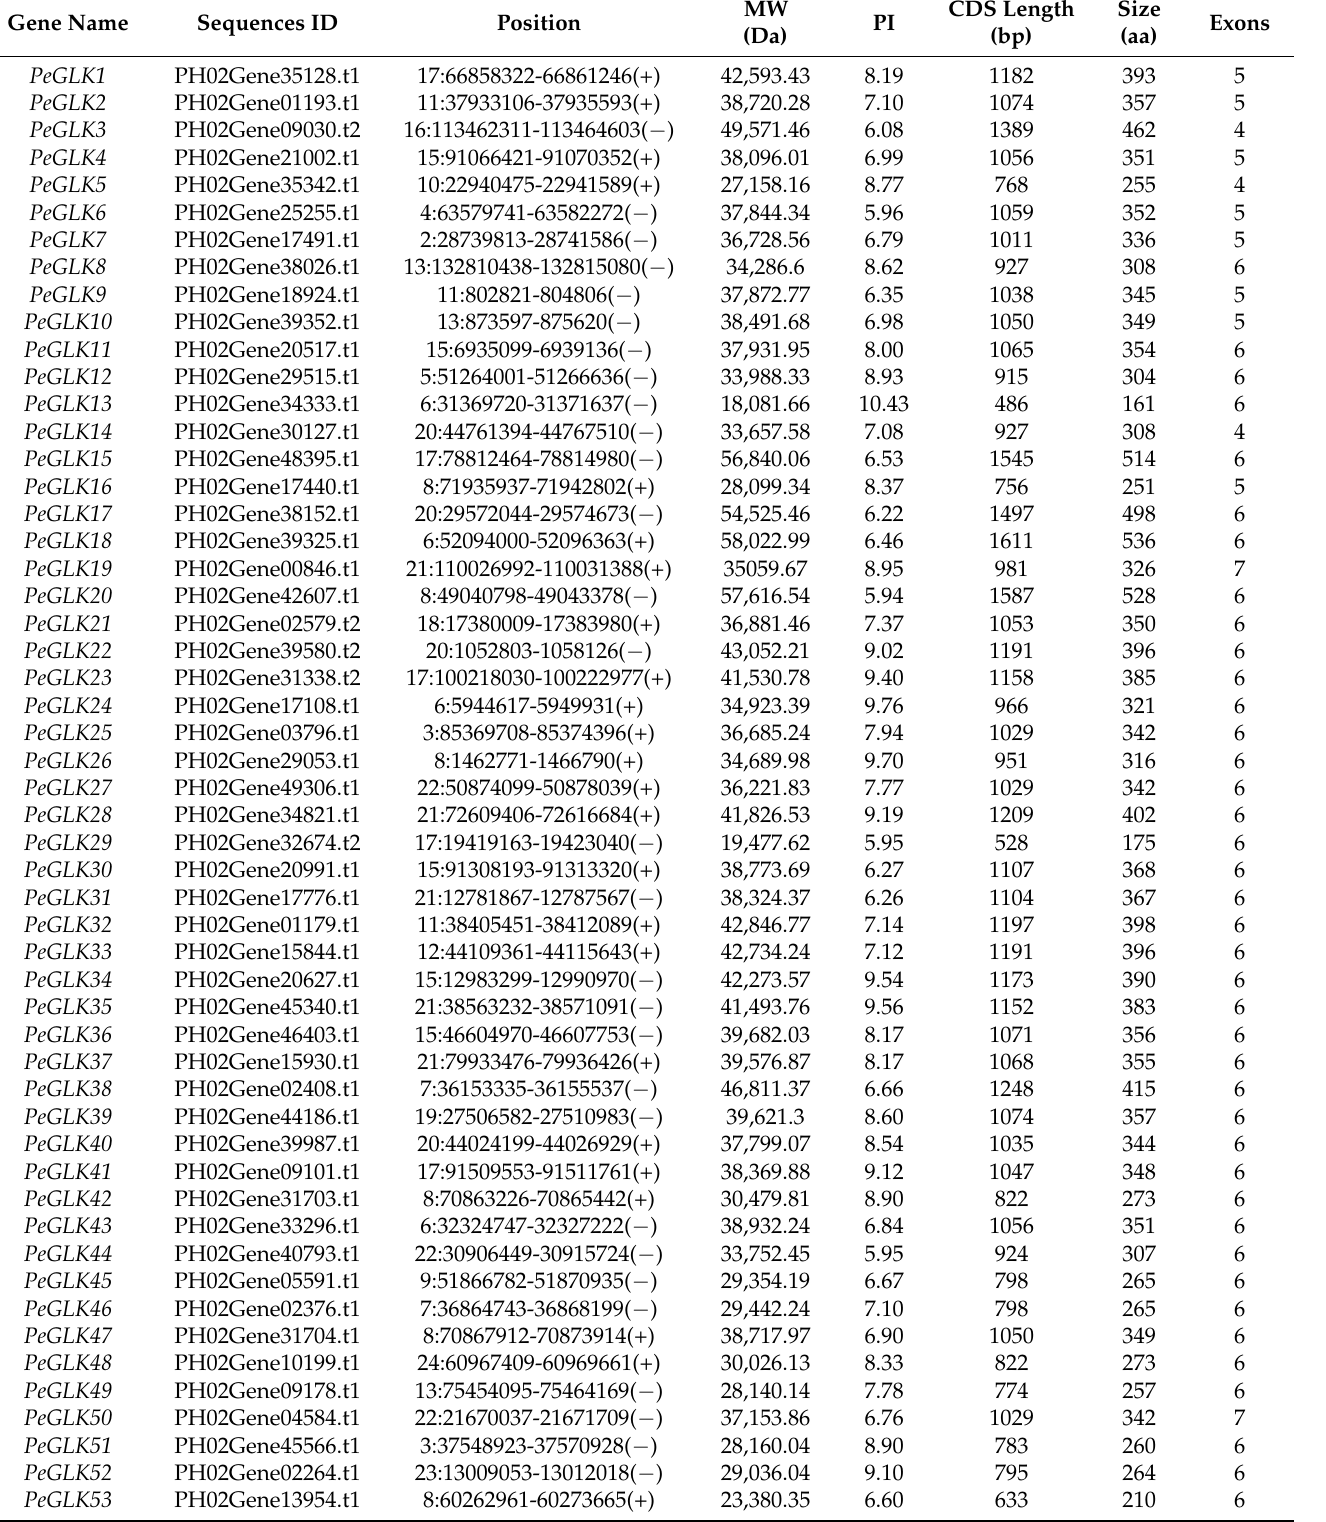
Table 1. Detailed information on 78 predicted PeGLK genes in Phyllostachys edulis . Last column lists gene ID, chromosomal locations, molecular weight (MW), protein isoelectric point (pI), and number of exons in each